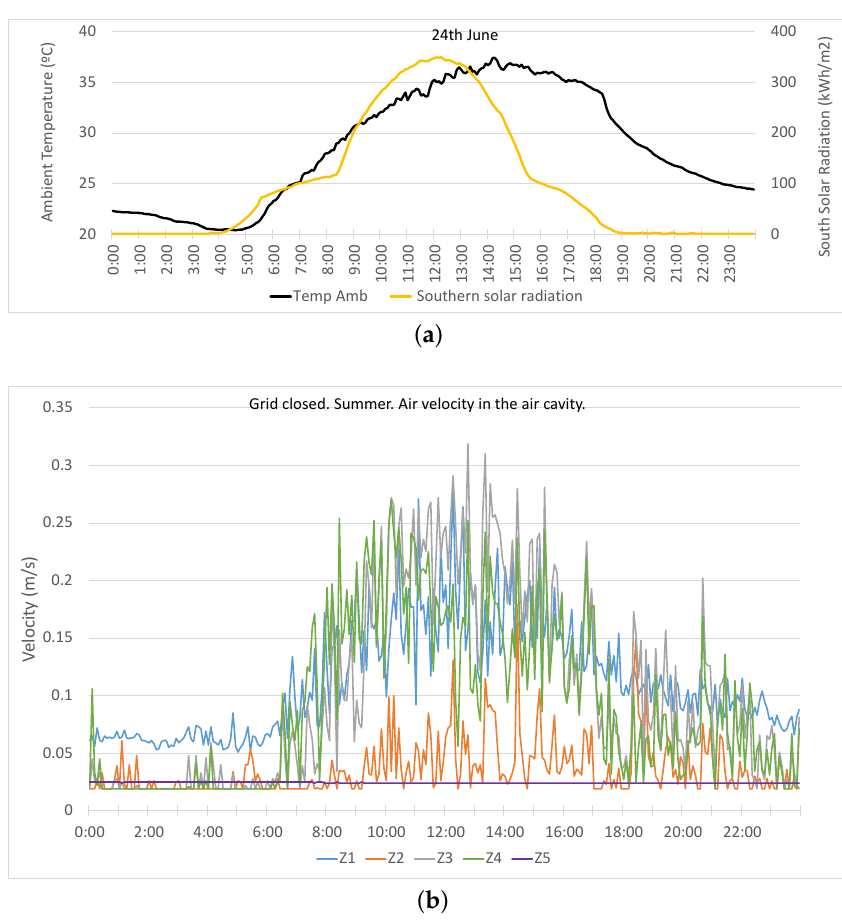
Figure 13. Closed ventilation grills, 24 June 2021: ( a ) south solar radiation and ambient temperatures; ( b ) trend of the measured air cavity velocities at the ventilated